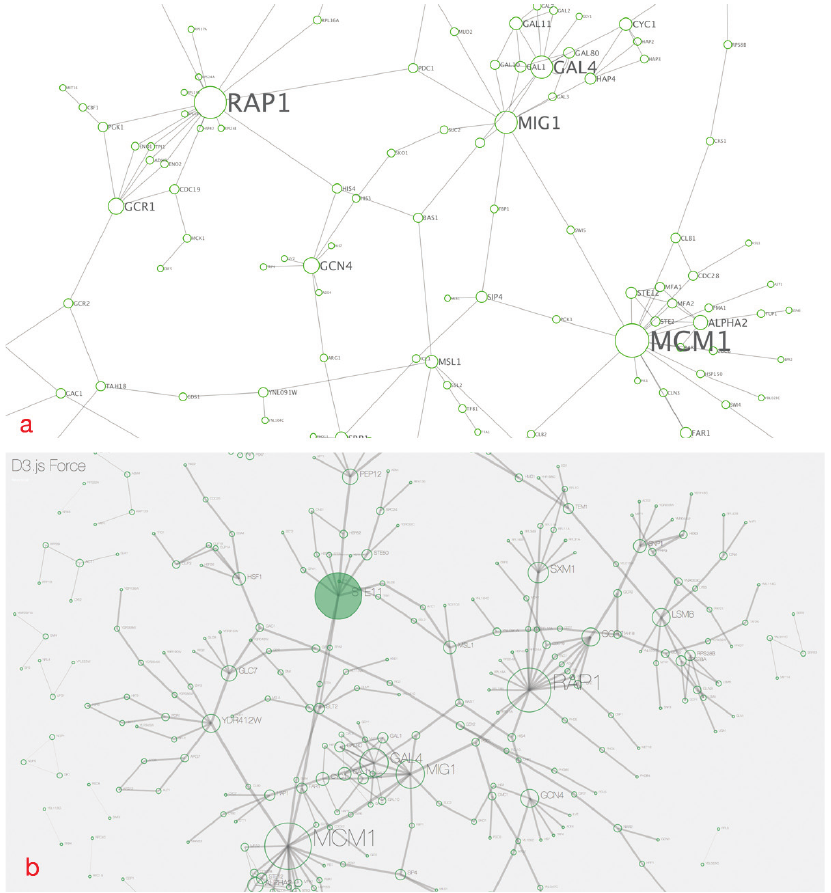
Figure 3. Visualization of a sample yeast protein-protein interaction network (galFiltered.sif from Ideker et al., Science 292:929 2001. Available as a sample file in Cytoscape 3 distribution) by a ) Cytoscape 3.1.1 and b ) D3.js force-layout.